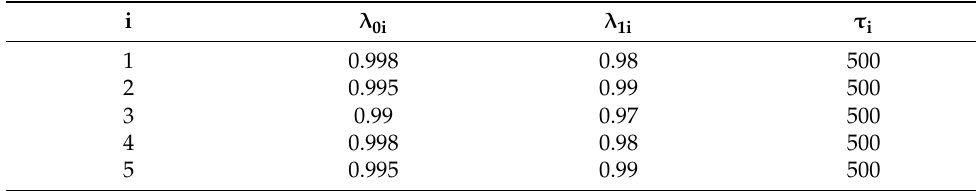
Table 1. Values for the calculation of forgetting factors λ wi .